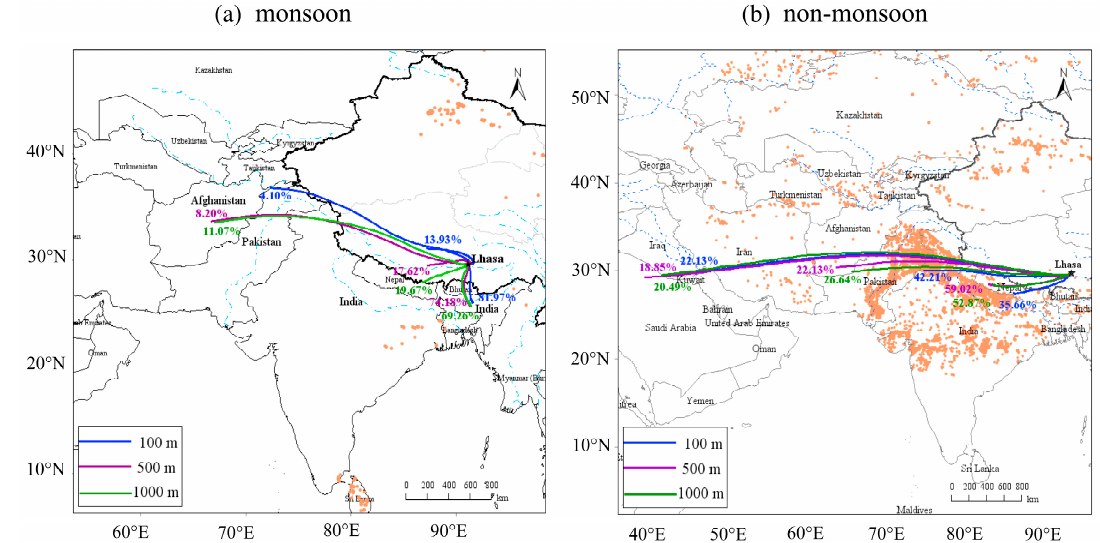
Figure 2. Backward trajectory diagrams containing the fire information during the monsoon and non-monsoon seasons.